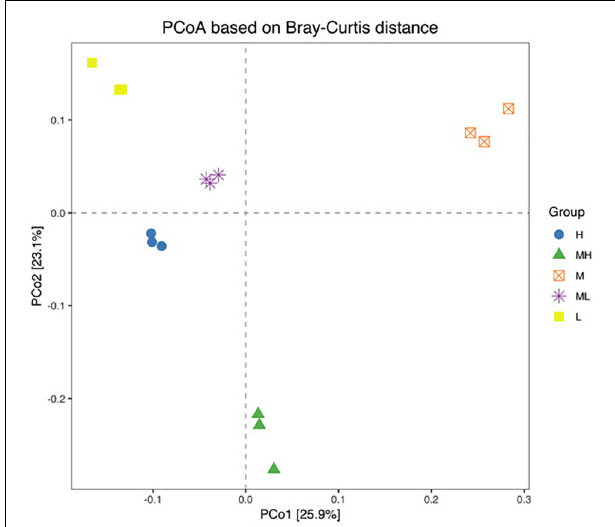
FIGURE 3 | Bray–Curtis distance matrix PCoA of rumen bacterial samples. H group: 33.0% peNDF 1 . 18 treatment. MH group: 29.9% peNDF 1 . 18 treatment.